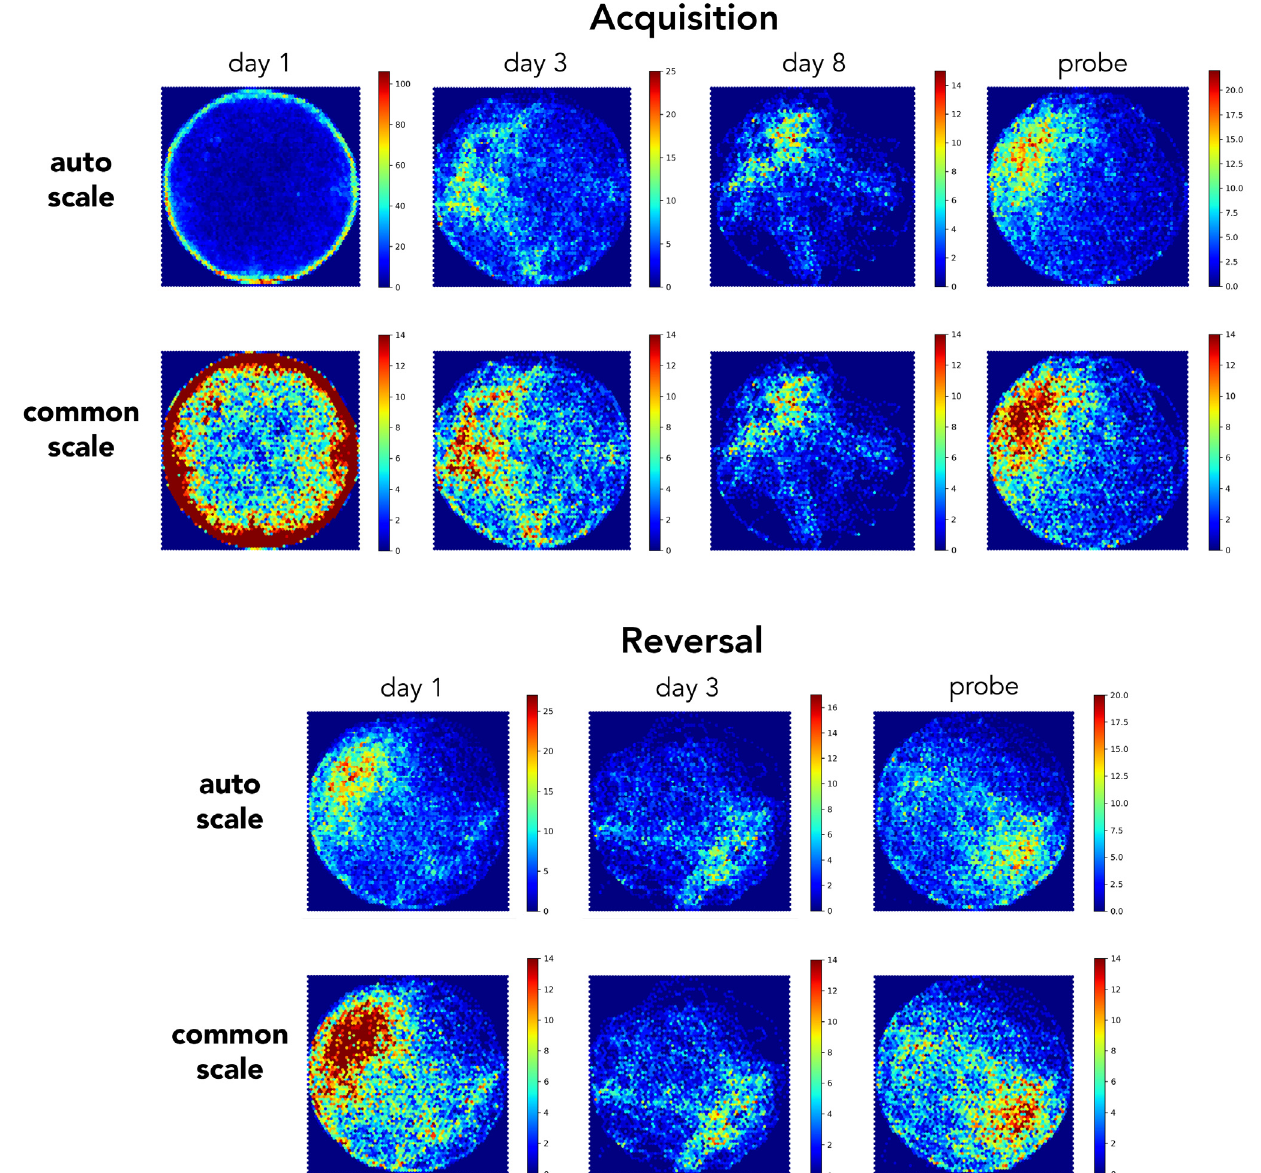
Figure 5. Heatmap visualization of spatial occupancy. Examples of heatmaps for various testing days (all trials from both sexes combined). Top rows: heatmaps were automatically scaled by Pathfinder, to occupy the full color spectrum and facilitate visualization of spatial occupancy within a given day. Bottom rows: heatmaps were set to a common scale, to facilitate comparison across days. Scale indicates number of samples within a spatial bin.